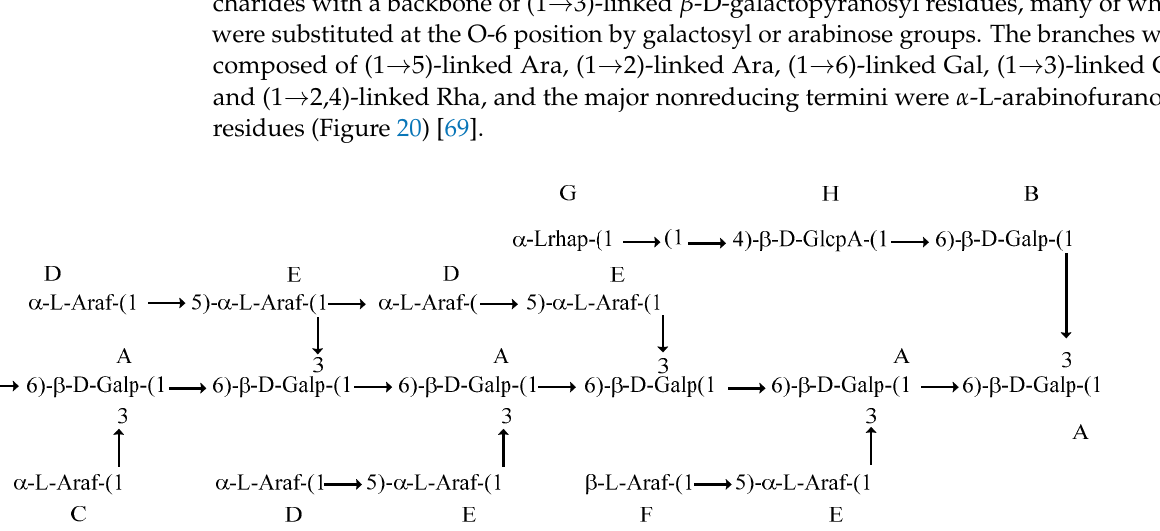
Figure 15. Possible structure of LBP1A1-1. Figure 16. Schematic representation of the sequential degradation procedure of LRGP3.